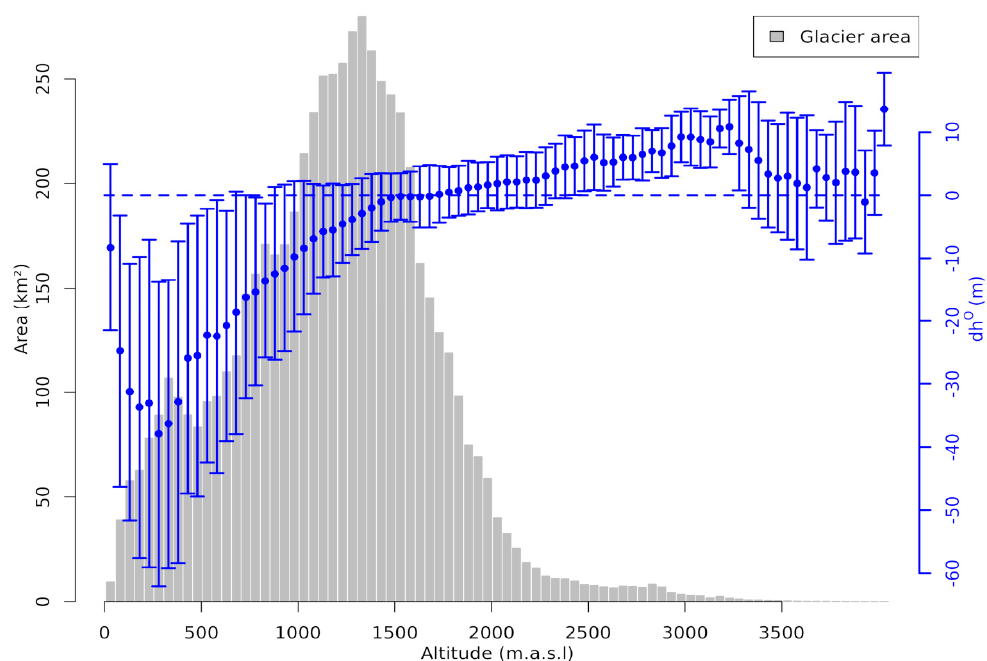
Figure 3. Hypsometric distribution of glacier area (gray bars) and surface elevation changes dh O (blue dots: mean dh O , error bars: median absolute deviation of dh O ) of the complete void-free data set (Correlation setup), grouped in 50 m altitude bins.